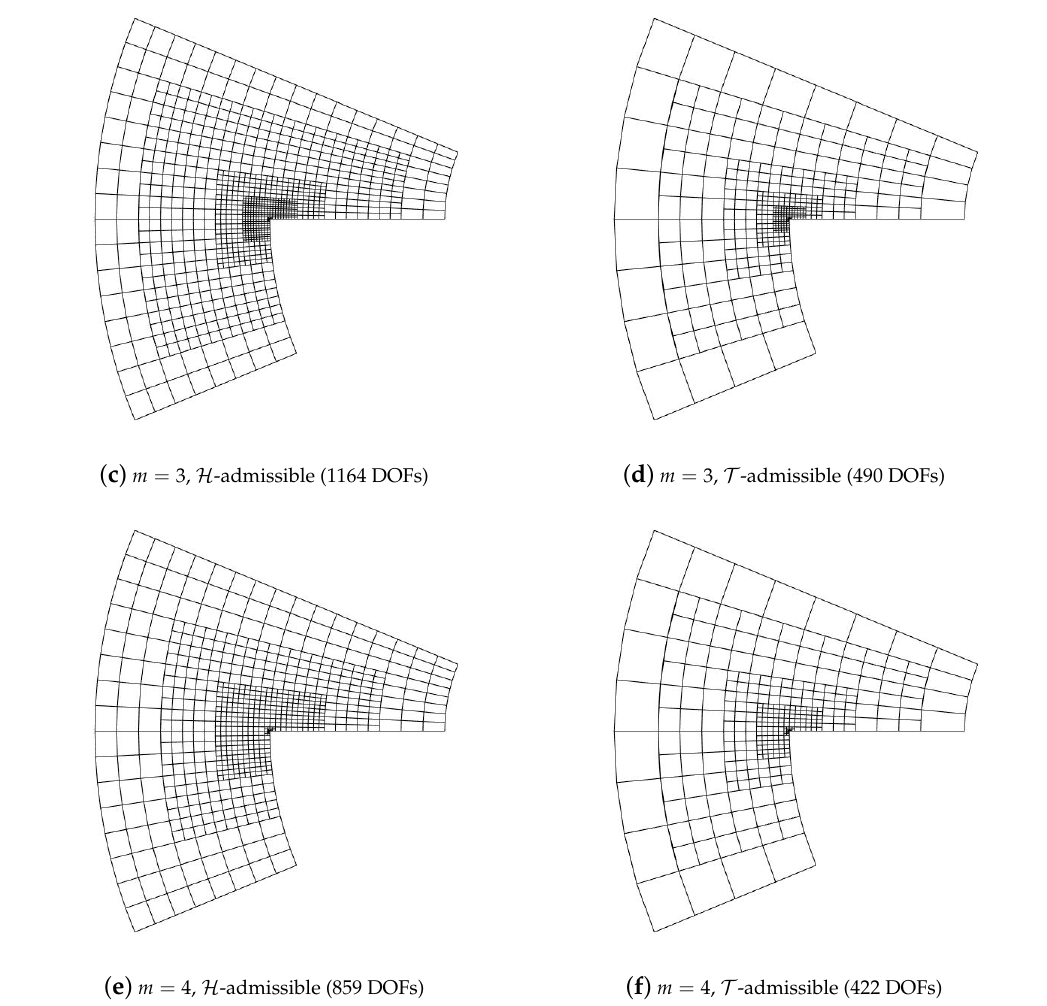
Figure 11. Hierarchical meshes obtained with p = ( 4,4 ) and m = 2,3,4 (from top to bottom ), by using H -admissible ( left ) and T -admissible ( right )